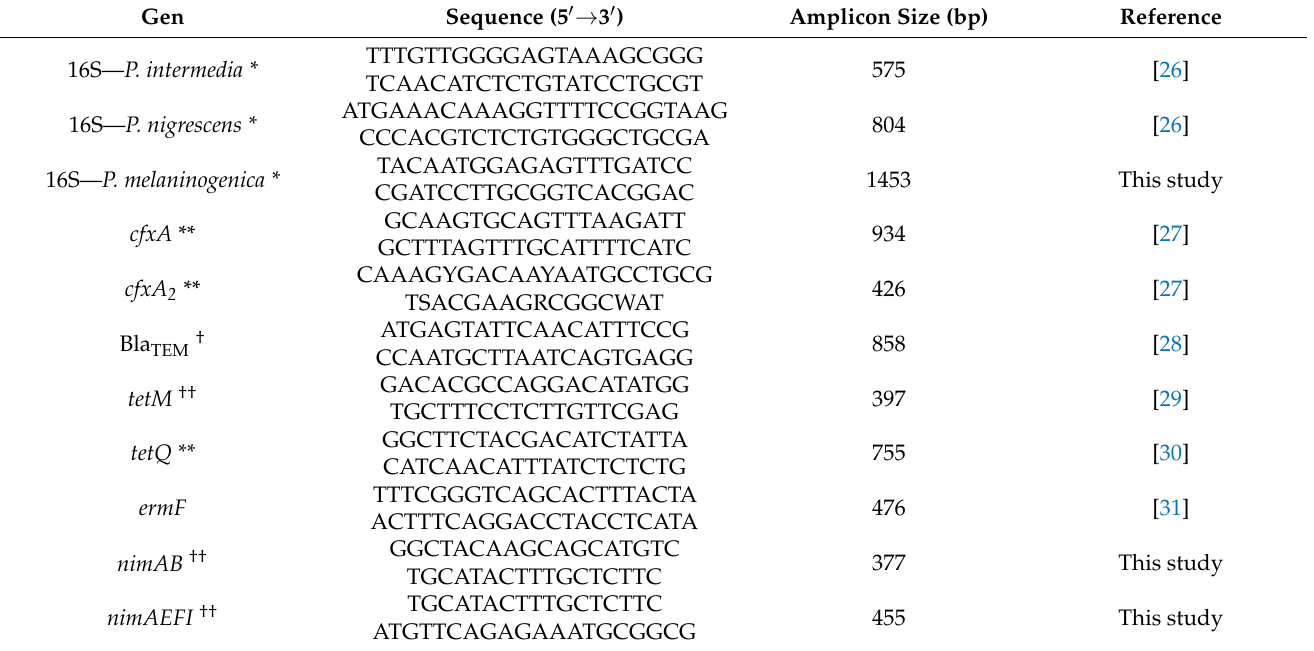
Table 5. Primer sequences for detecting species and resistance